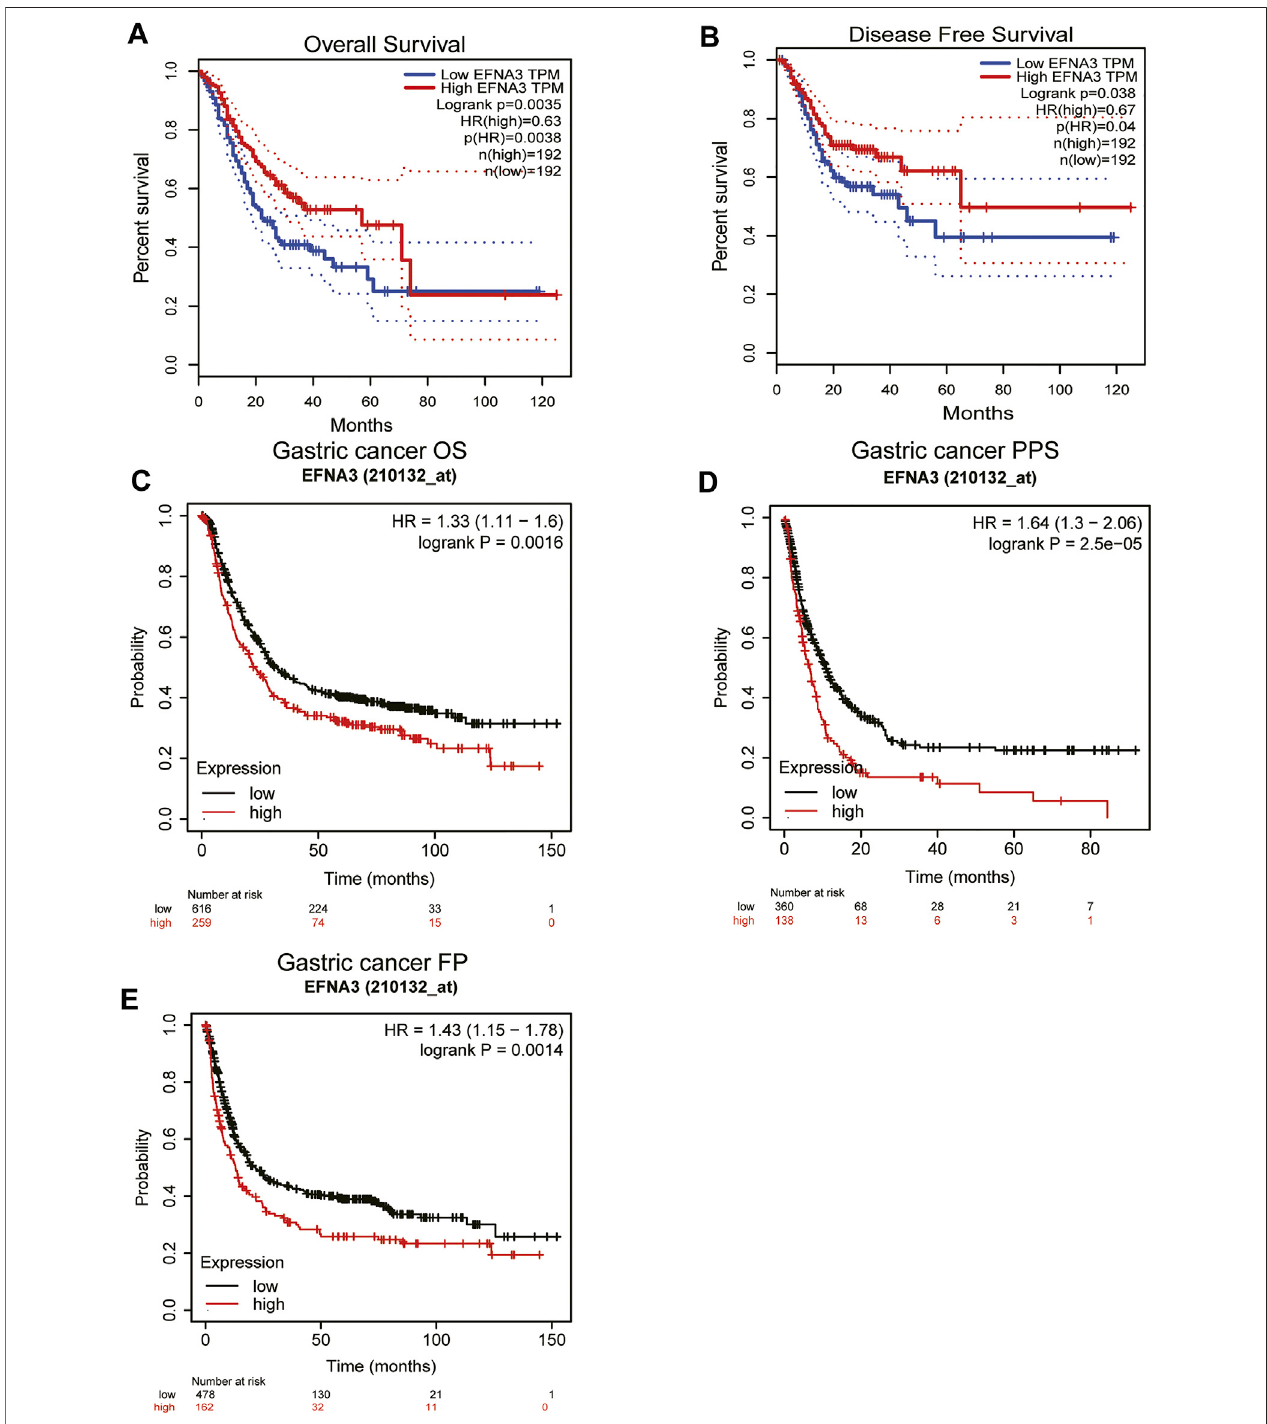
FIGURE 2 | Correlation of EFNA3 expression with prognostic value in GC. Survival curves of differential EFNA3 expression were analyzed using GEPIA2 (A, B) . CorrelationbetweenEFNA3and prognosisofSTADintheKaplan-Meier plotdatabase (C – E) .OS,overallsurvival;DFS,disease-freesurvival;FP,fastprogression;PPS, post-progression